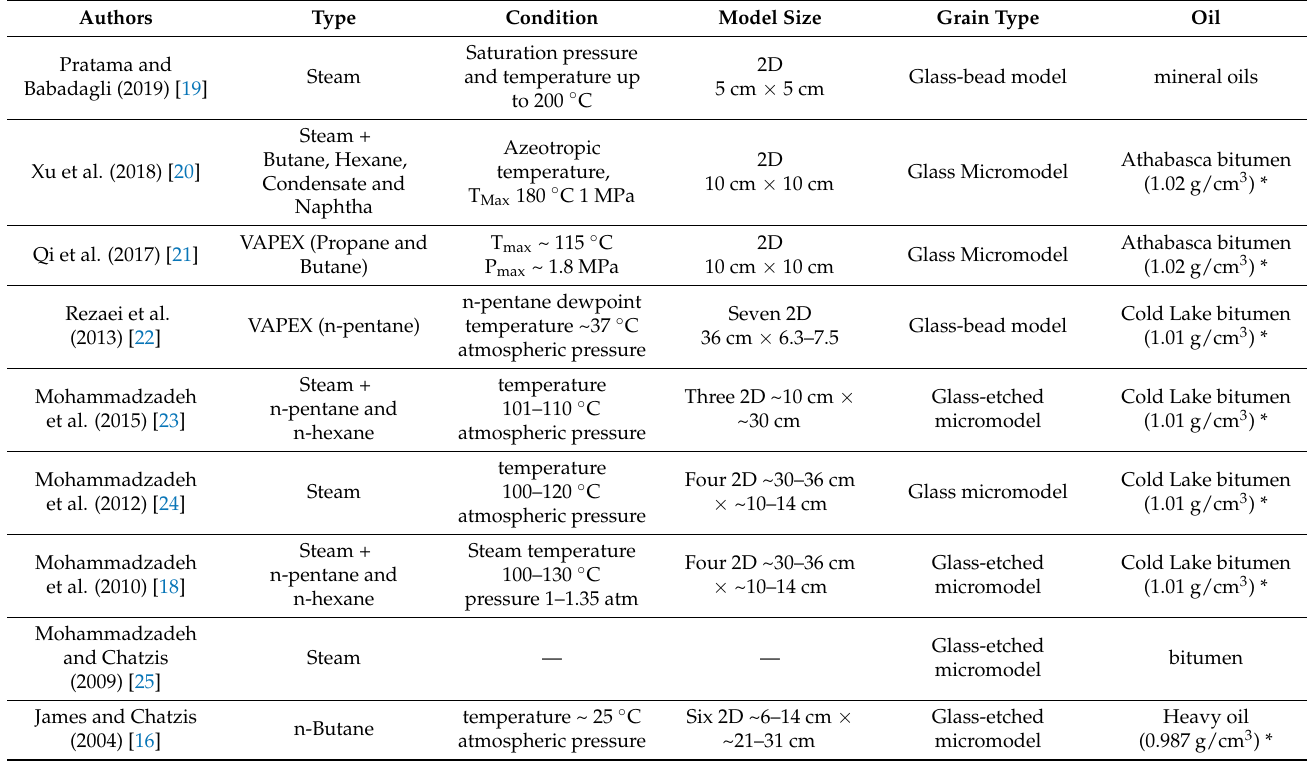
Table 1. Pore-scale experimental